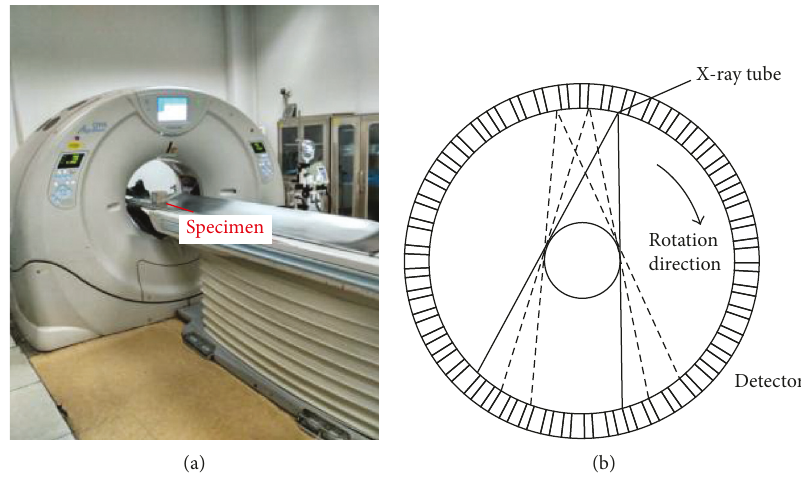
Figure 5: A schematic diagram of CT scanner process and the sketch of its working principle.